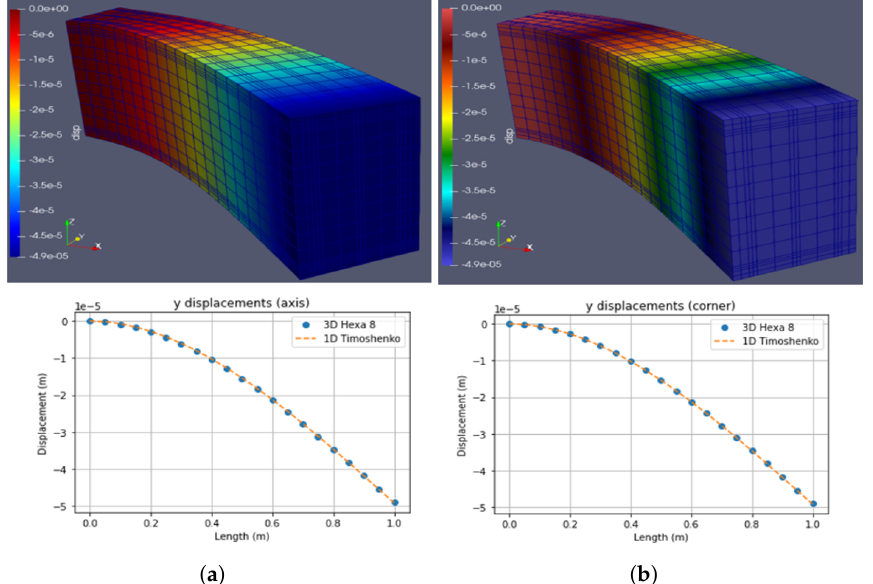
Figure 9. Case 2: Horizontal (y) load at the end of the beam (1000 N). ( a ) Hexa8. ( b ) Timoshenko. (Note: e − n indicates 10 − n